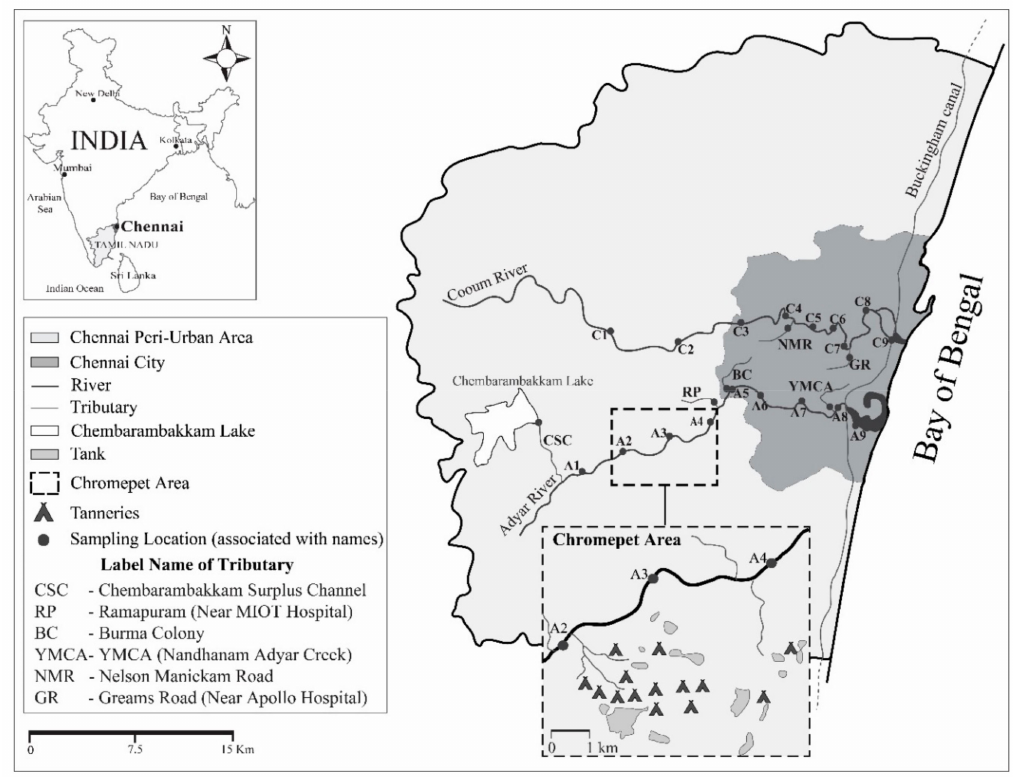
Figure 1. Study area showing the sampling sites in Chennai (Tamil Nadu,